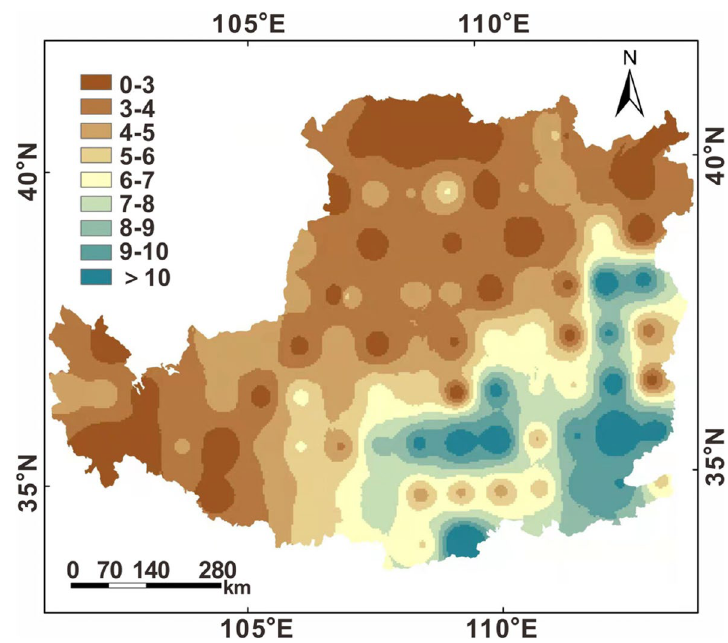
Fig. 2 Spatial pattern of ecosystem total carbon density (ETCD) along longitude and latitude across the Loess Plateau